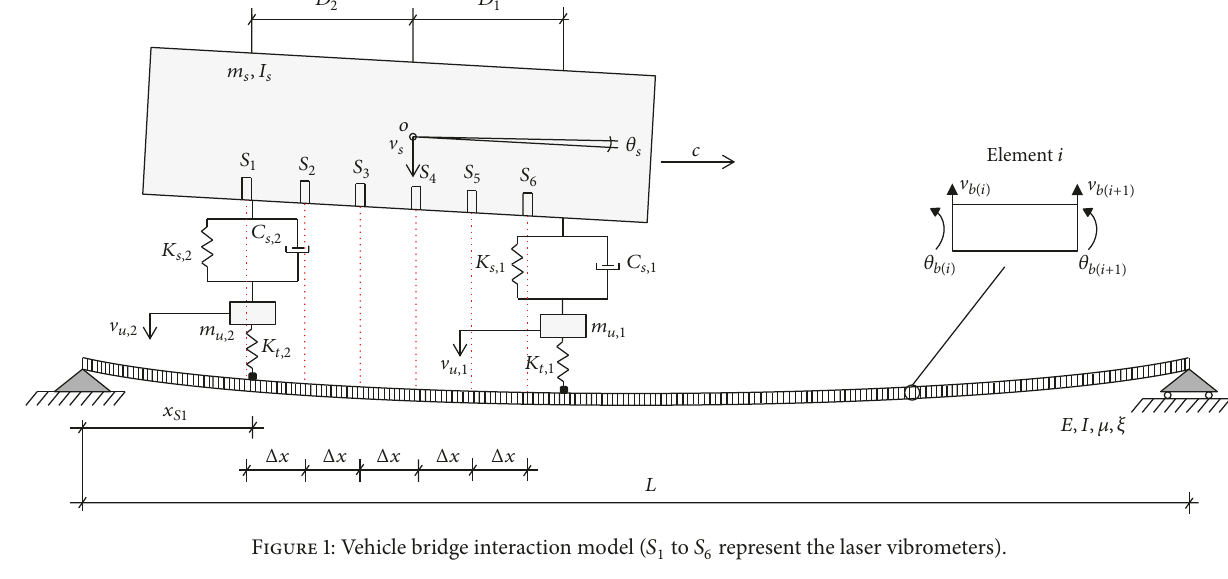
Figure 1: Vehicle bridge interaction model ( 𝑆 1 to 𝑆 6 represent the laser vibrometers).